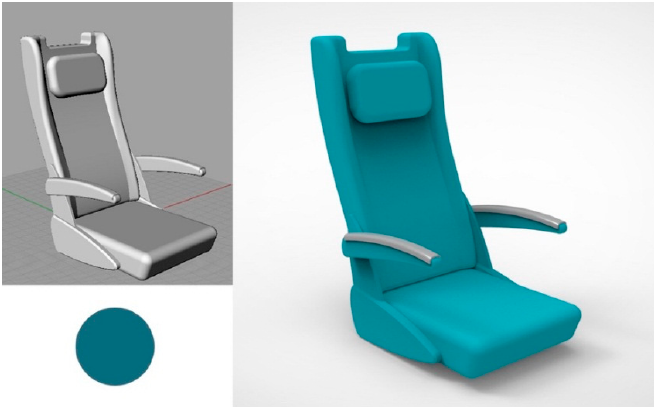
Figure 14. The train seat rendering of the form sample 3 filled with the color sample 1.